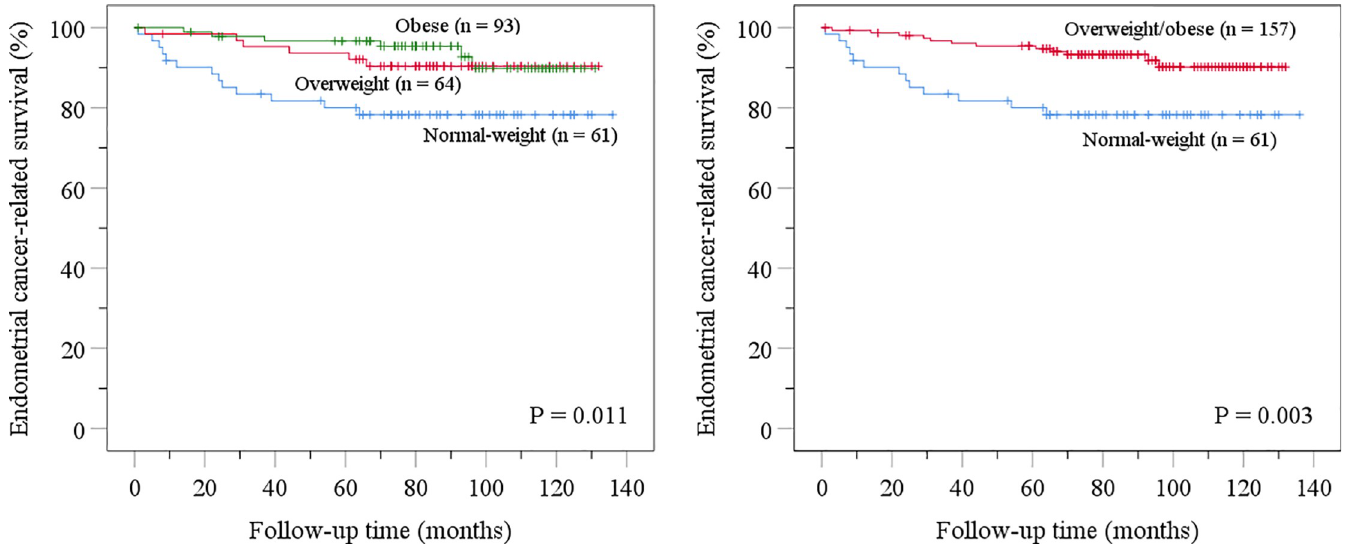
Fig 1. Kaplan-Meier disease-specific survival analyses concerning body mass index in the “no specific molecular profile” subgroup.